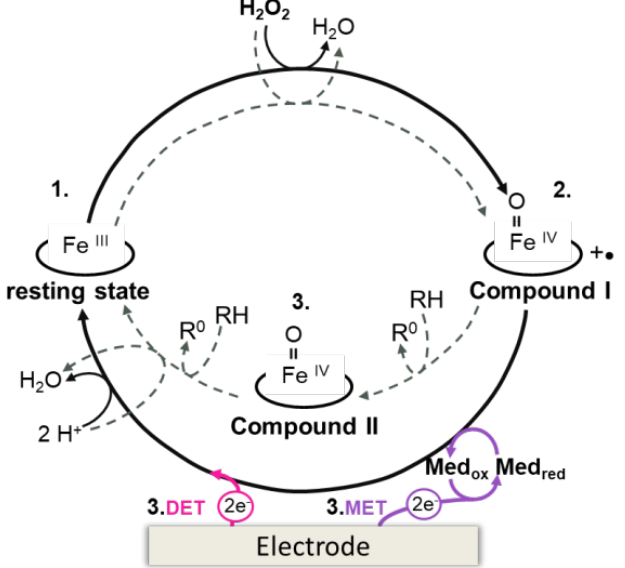
Figure 5. Reaction scheme of peroxidase-based electrochemical biosensors (solid lines) and of the native catalytic cycle (dashed lines). RH—substrate; R ◦ —product; Med ox —oxidized mediator; Med red —reduced mediator; DET—direct electron transfer; MET—mediated electron transfer.